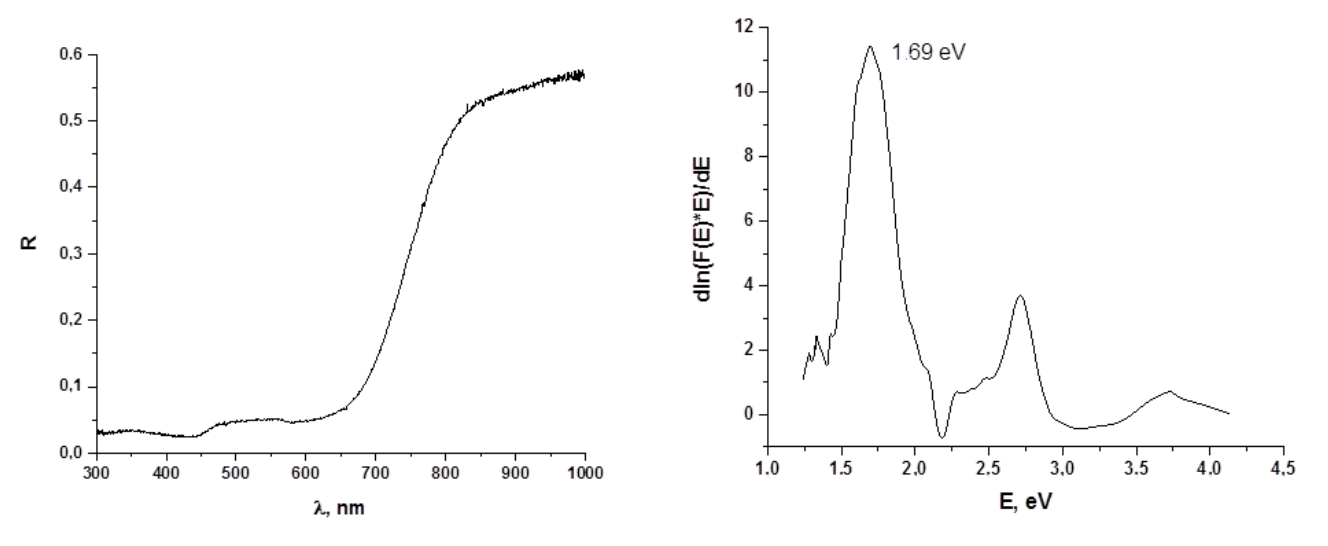
Figure 7. Diffuse reflectance spectrum ( left ) and optical band gap determination (Tauc coordinates, right ) for 2 .